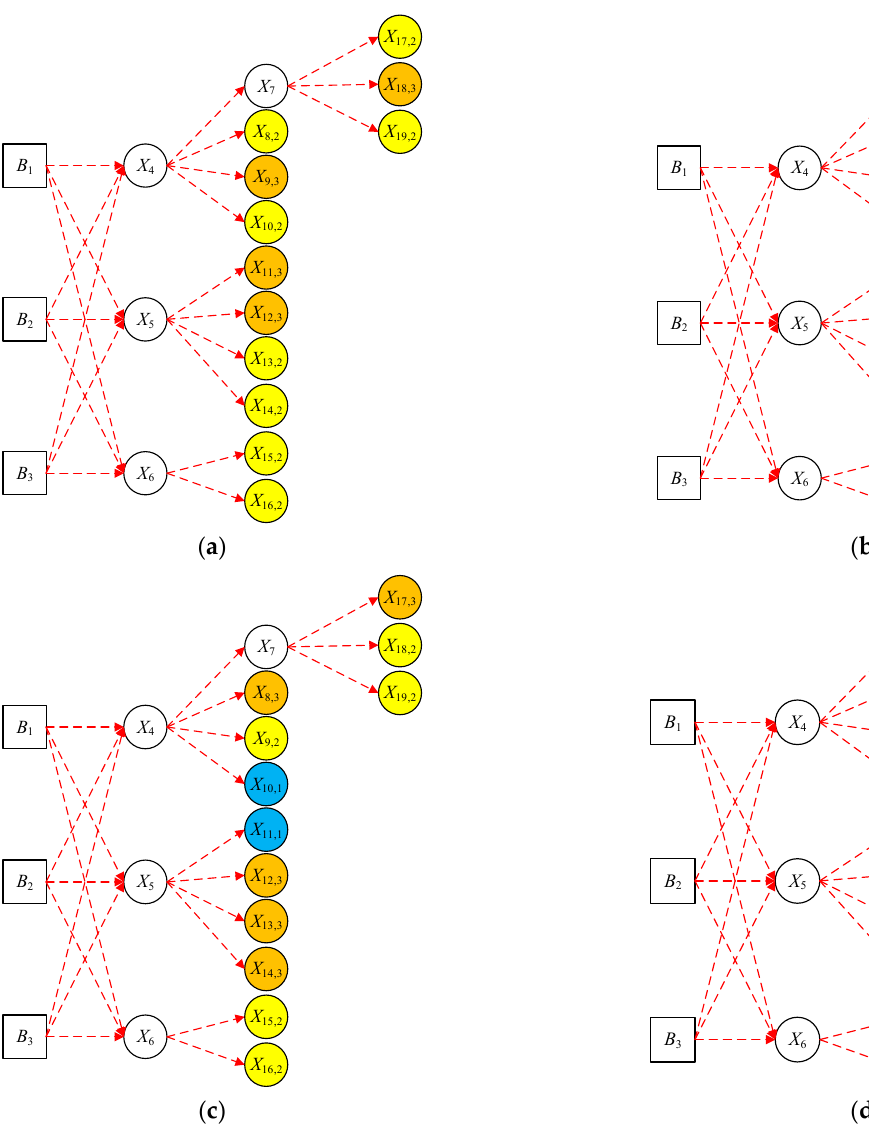
can be converted into Figure 9.